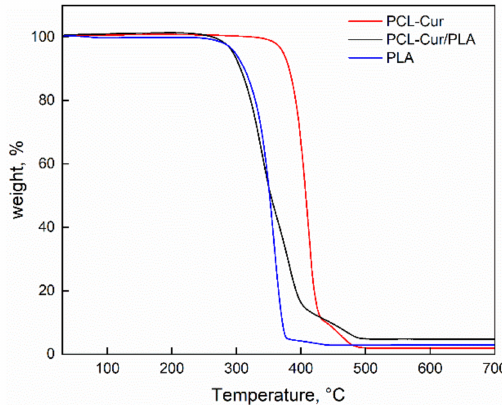
Figure 3. Thermogravimetric analysis of PCL-Cur, PCL-Cur/PLA and PLA.